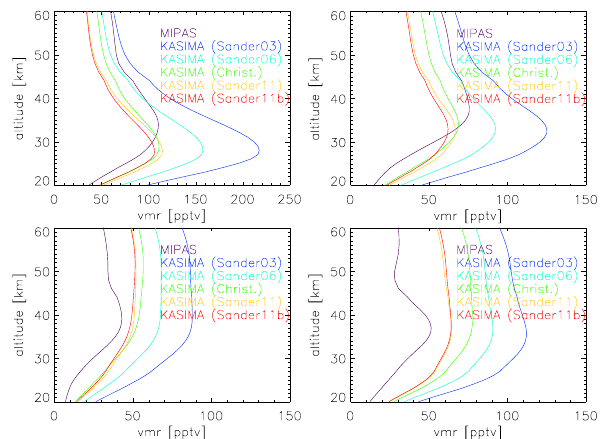
Fig. 8. Mean profiles for MIPAS measurements (purple) and KASIMA model results with MIPAS A applied with JPL recom- mendation for R1 from Sander et al. (2003) (blue), Sander et al. (2006) (turquoise), Christensen (green), Sander et al. (2011) (or- ange) and Sander et al. (2011) with updated HO x reactions (red); top left: 20 ◦ S to 20 ◦ N; top right: 30 ◦ N to 60 ◦ N; bottom left: 70 ◦ N to 90 ◦ N; bottom right: 70 ◦ S to 90 ◦